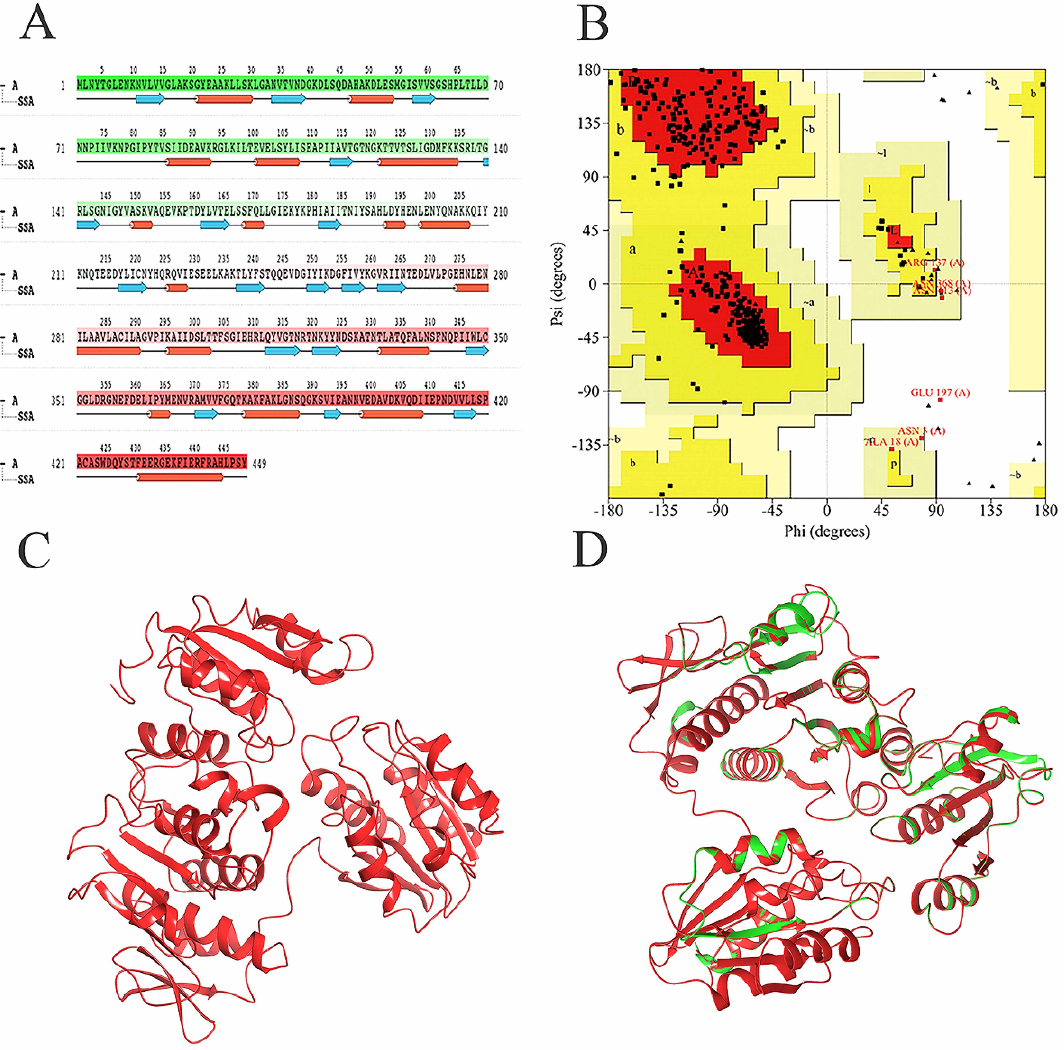
Figure 1. Demonstration and validation of MurD enzyme modeling proteins. ( A ) MurD Ligase sequence of S. aureus. ( B ) The Laplace diagram verification of S. aureus MurD Ligase represents 358 residues in the most favored region (red), 39 residues in the additional allowable region (yellow), 5 residues in the generous allowable region (light yellow), and 1 residue in the prohibited region (white). ( C ) Homologous model of MurD Ligase of S. aureus. ( D ) 3D comparison between MurD Ligase model shown in red and MurD crystal structure of Streptococcus agalactiae shown in green (PDB: 3lk7) as template.